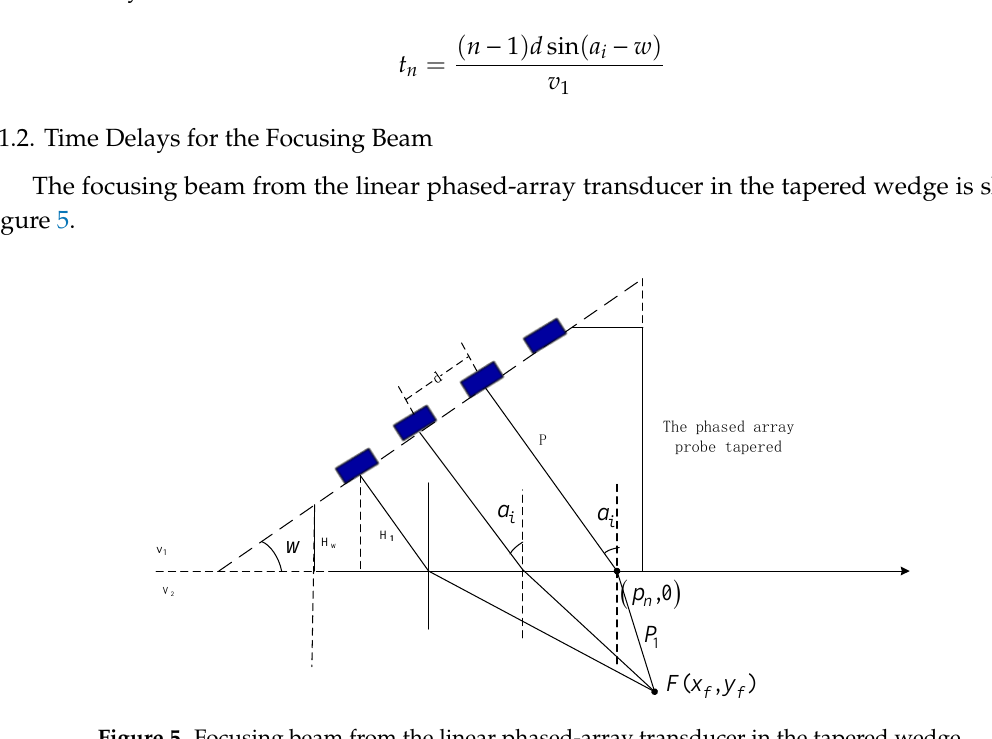
O' E Figure 6. Schematic of the wedge after grinding.